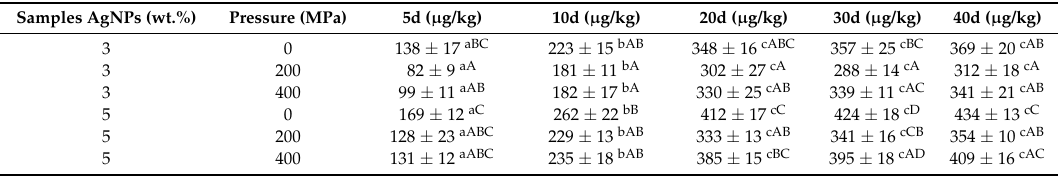
Table 4. Effect of high pressure treatment on the migration behavior of PLA/AgNPs nanocomposite films. Samples AgNPs (wt.%) Pressure (MPa) 5d ( µ